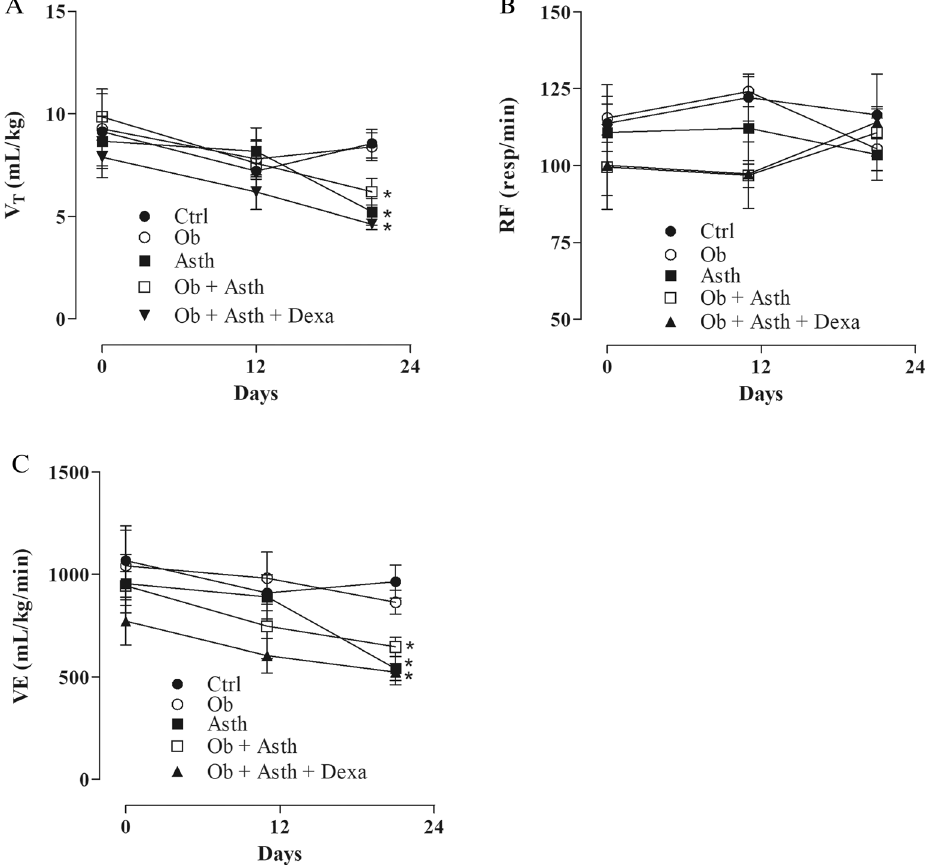
Figure 5. Evaluation of ( A ) tidal volume (VT), ( B ) respiratory frequency (RF), and ( C ) ventilation (VE) on days 1, 12 and 21 of asthma induction. Symbols and vertical bars represent the mean and the e.p.m., respectively. One-way ANOVA followed by Tukey’s posttest (n = 6). * p < 0.05 (Ctrl vs. Asth, Ob + Asth and Ob + Asth +